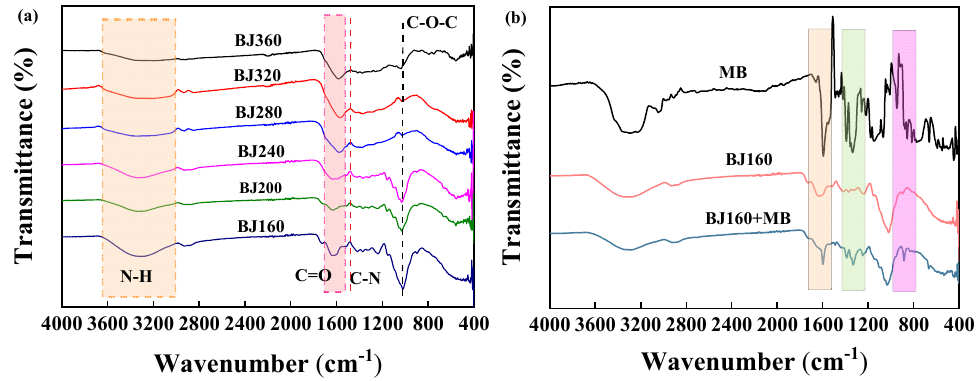
Figure 2. FT-IR spectra of PoBJ biochar: ( a ) BJ prepared at different pyrolysis temperatures; ( b ) MB, and BJ160 pre- and post-adsorption of MB.